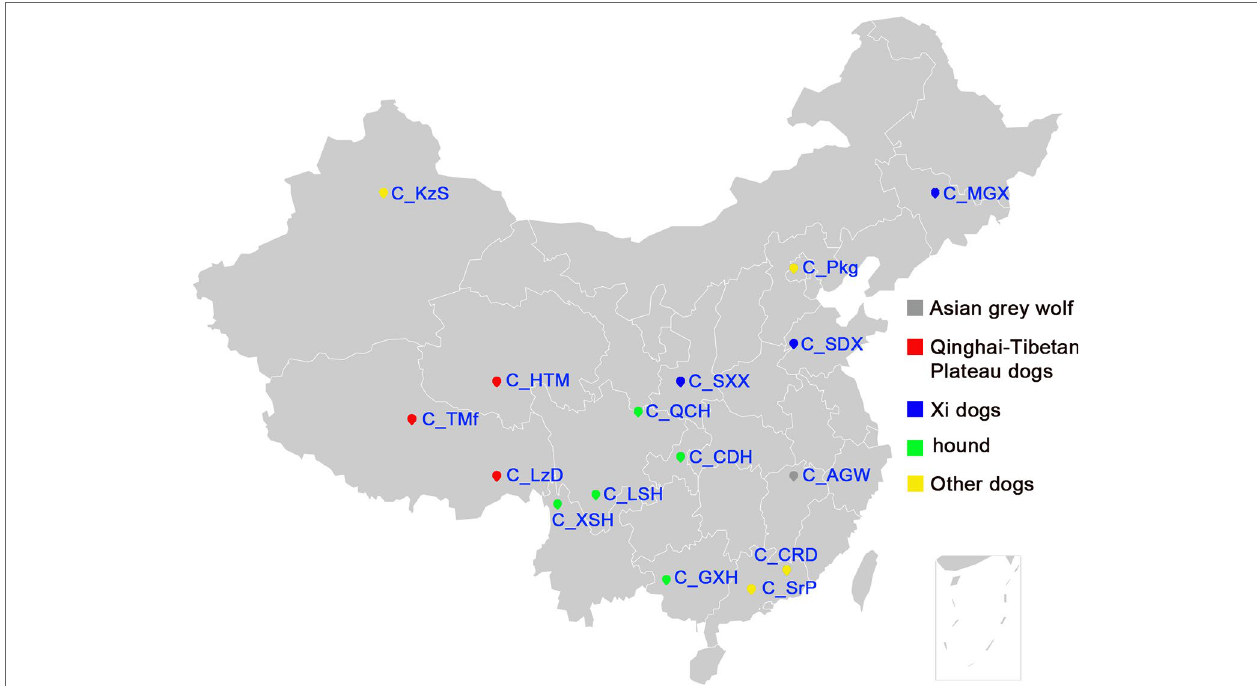
FIGURe 1 | The geographic locations of Chinese indigenous dogs. The geographical distribution of sampled Chinese indigenous dogs, the full name of each breed is listed in Table 1